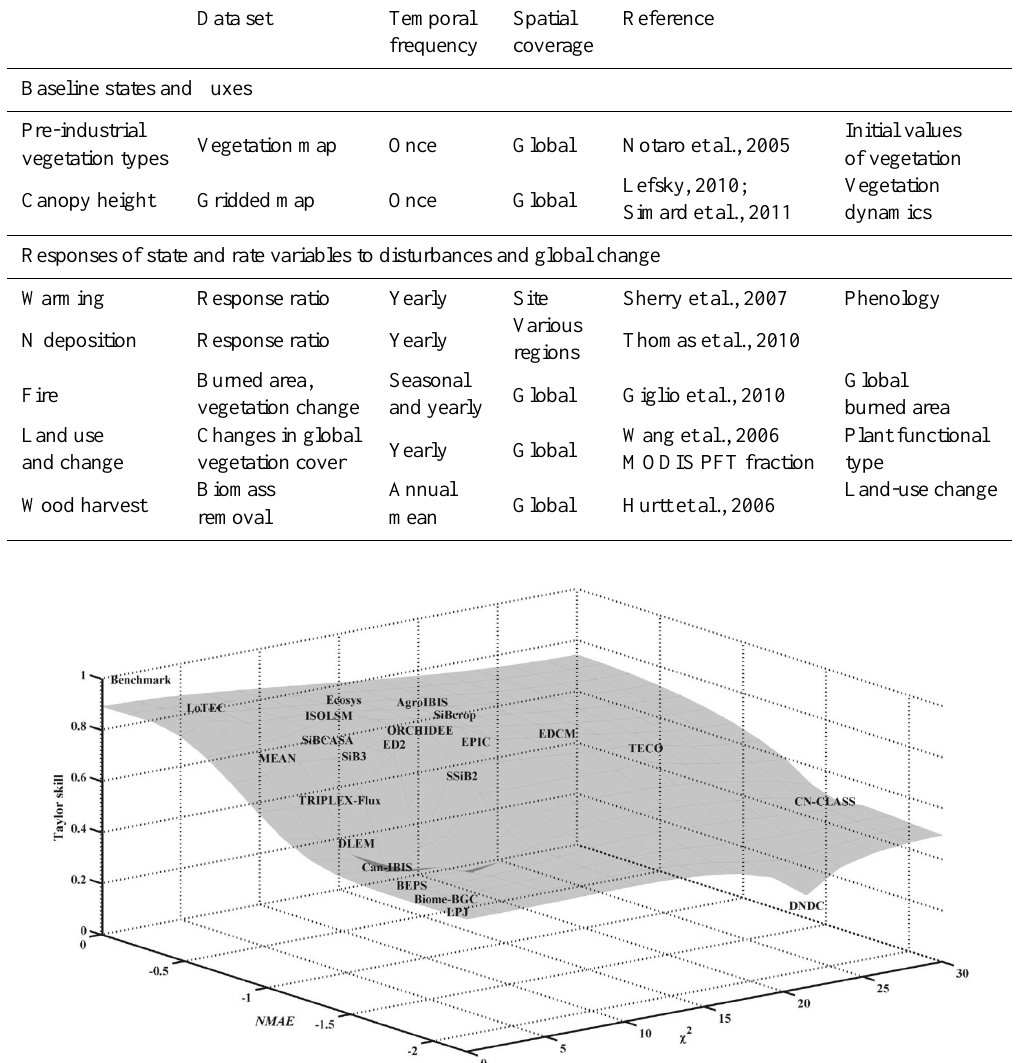
Fig. 6. Model skill metrics for 22 terrestrial ecosystem models. Skill metrics are Taylor skill ( S ), normalized mean absolute error (NMAE), and reduced chi-squared statistic ( χ 2 ). Taylor skill is used to represent the degree to which simulations matched the temporal evolution of monthly NEE; NMAE quantifies bias, i.e., the “average distance” between observations and simulations in units of observed mean NEE; χ 2 is used to quantify the squared difference between paired model and data points over observational error normalized by degree of freedom. Better model–data agreement corresponds to the upper left corner. Benchmark represents perfect model–data agreement: S = 1, NMAE=0, and χ 2 = 1. Gray interpolated surface added and model names attached to improve readability. Model details are given in Schwalm et al.